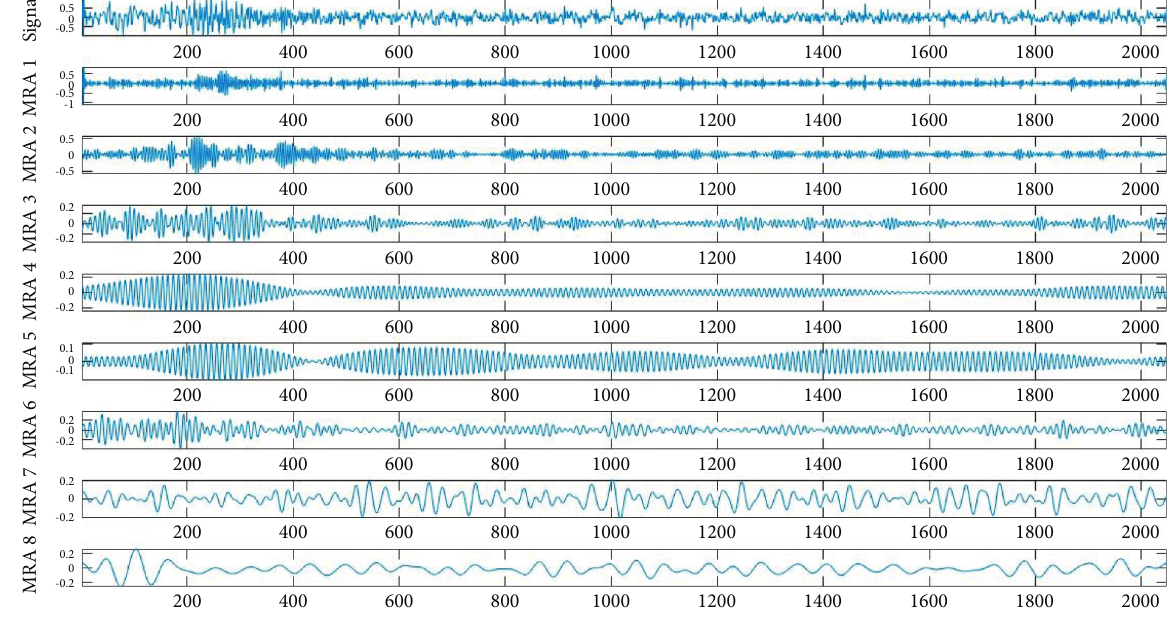
Figure 7: Signal of the motor in good condition and its